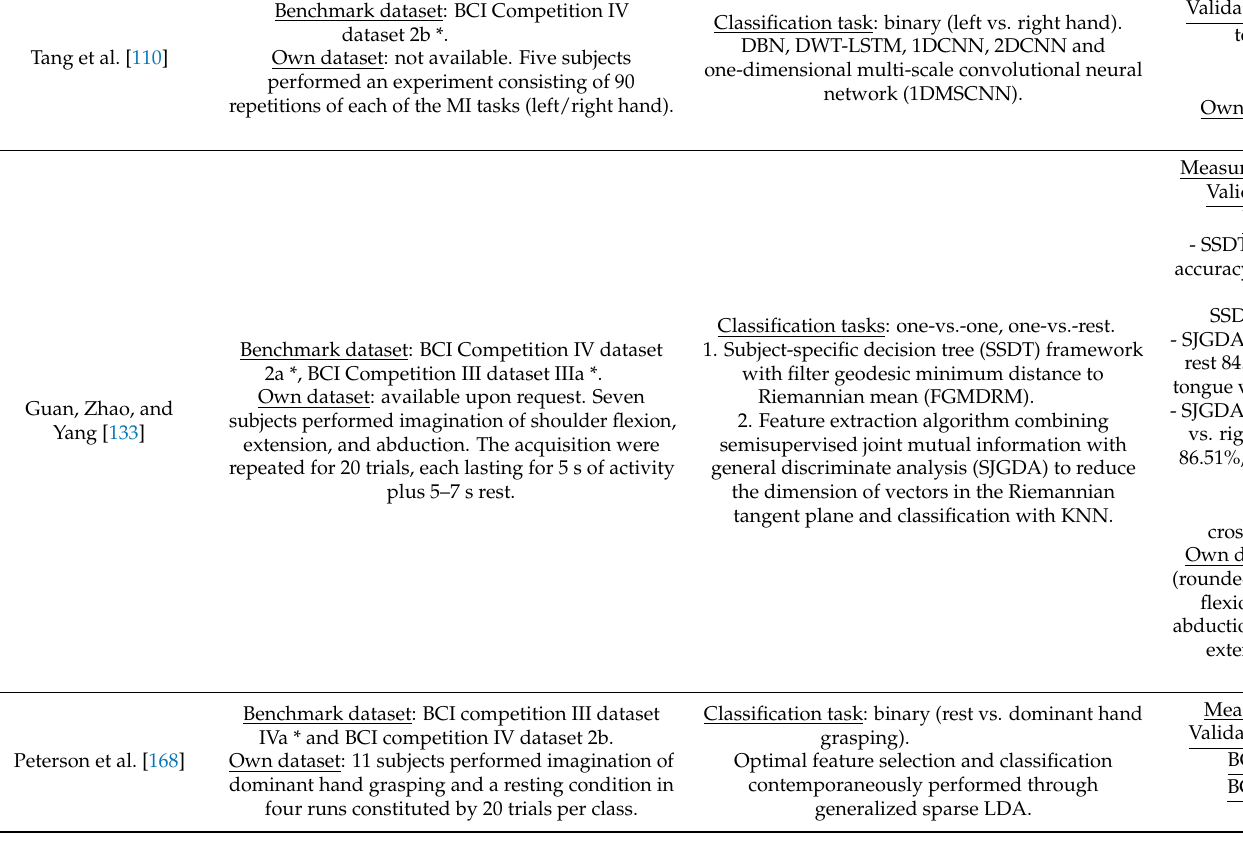
Table 5. Synthetic information on works presenting classification and other analyses, while comparing their results with benchmark datasets or their own available upon request or published datasets. An asterisk (*) has been applied to all the datasets that will be detailed in Section 5.4, at their first appearance. Reference Dataset and Experimental Paradigm Classification and/or Other Analyses Performance of the Best Method Online and/or Offline Benchmark dataset: BCI Competition IV dataset 2b *. Tang et al. [110]